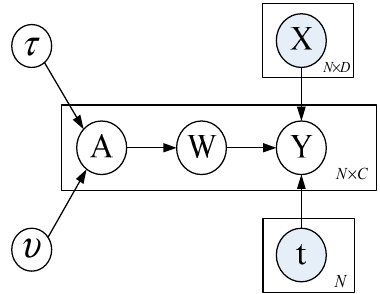
Figure 2. Schematic diagram of the hierarchical Bayesian model.